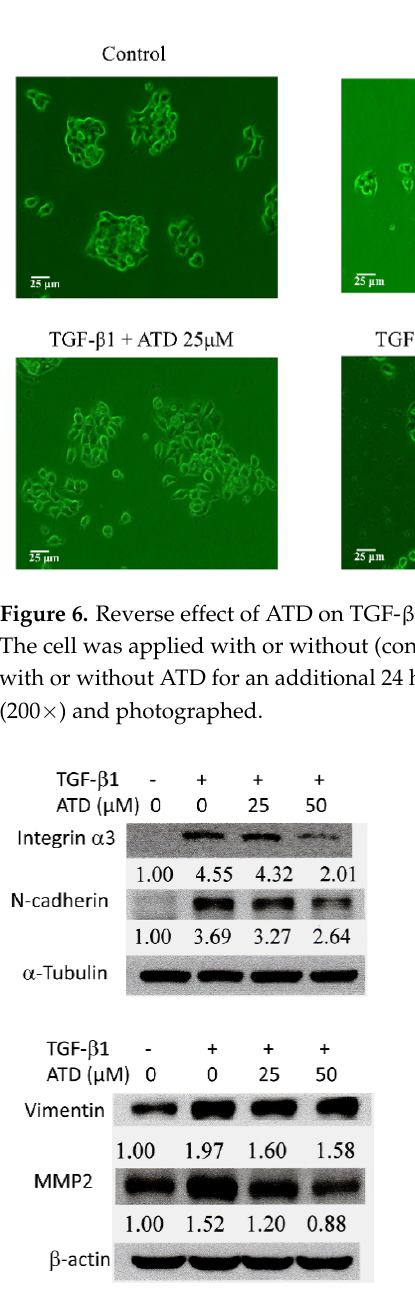
8 of 14 Figure 5. Effect of ATD on TGF- β 1-promted growth in HepG2 hepatoblastoma cells by colony for- mation assay. After treatment with ATD or cotreatment ATD and TGF- β 1 for 24 h, 1000 cells were seeded on 6-well plate and cultured for 2 weeks, then cells were fixed with methanol and stained with crystal violet. Colony numbers were quantified by ImageJ software. Data are represented as the mean ± SD from the three independent experiments. # p < 0.05, ## p < 0.01, #### p < 0.0001, com- pared with the control group treated (0.2% DMSO). ***: TGF- β 1 vs . TGF- β 1+ 25 μ M ATD, p < 0.001; ****: TGF- β 1 vs . TGF- β 1+ 50 μ M ATD, p < 0.0001. 3.4. Effect of ATD on TGF- β 1-Induced Cell Scattering